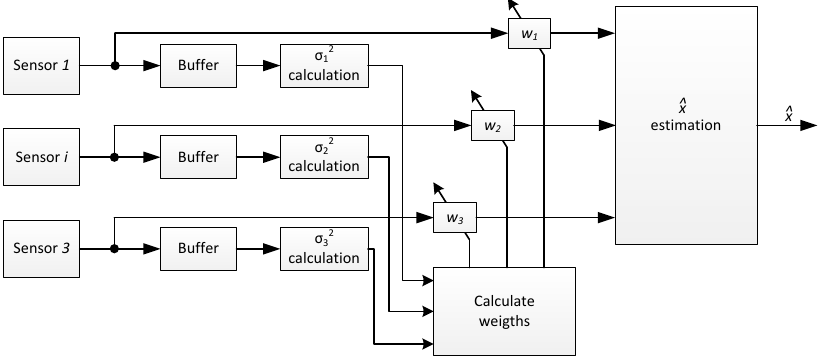
Figure 12. Proposed weighting algorithm for ˆ x estimates using three